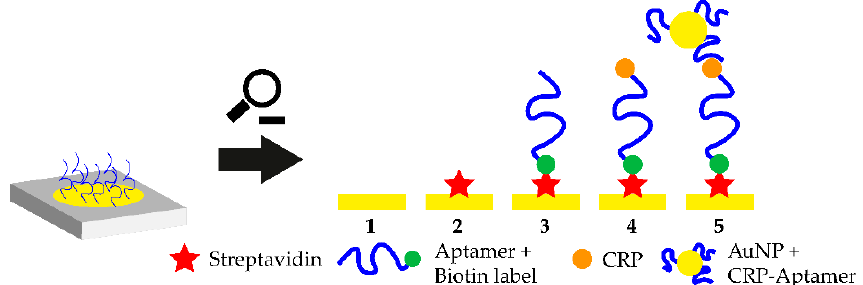
Figure 4. Close-up of the working principle of the smartphone-assisted sensor platform. Streptavidin is immobilized on a gold coated surface and the biotinylated CRP-aptamer is added. Biotin binds to the immobilized streptavidin and the aptamer binds to circulating CRP. Then, aptamer-modified gold nanoparticles (AuNPs) are added which bind to a different epitope on the CRP molecule. The shift in the surface plasmon resonance (SPR) wavelength is monitored with a smartphone-assisted device and CRP concentration can be measured.